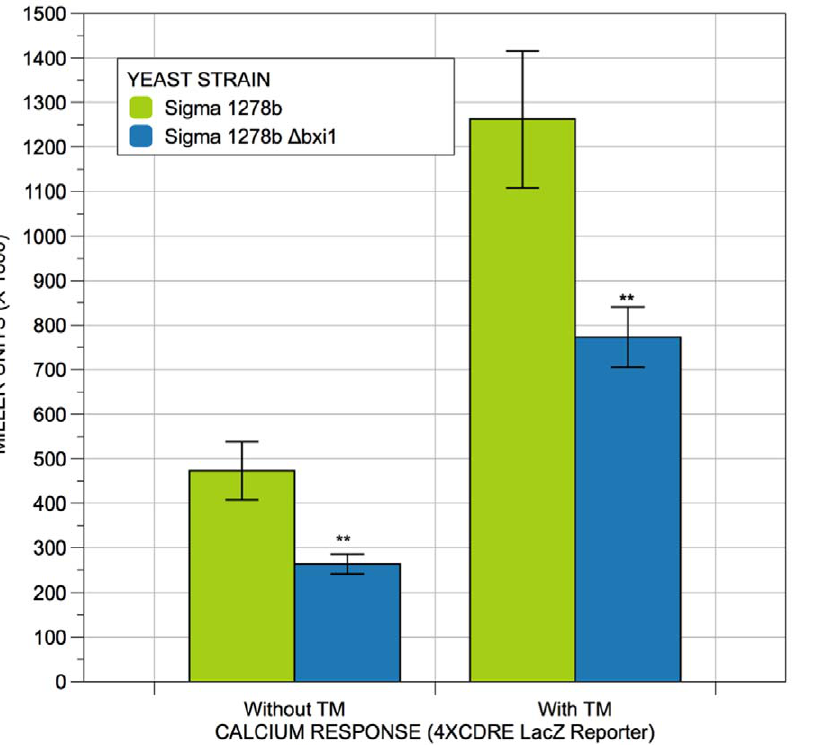
Figure 7. Deleting BXI1 diminishes calcium signaling in the absence and presence of unfolded proteins in the ER. Cells of the indicated genotype in the S 1278b strain background were transformed with a 4XCDRE-lacZ reporter, grown overnight in selective media at 30 u C. They were then resuspended in fresh media and allowed to reach exponential phase (an approximate OD 600 value of 0.4). Next, they were resuspended in fresh media or in fresh media containing 0.6 m g/ml TM and allowed to grow at 30 u C for three hours. b -galactosidase assays with the colorimetric substrate o -nitrophenyl- b -D-galactopyranoside (ONPG) were then performed and quantified using the permeabilized cell method as previously described. [37,41,42] The differences in b -galactosidase levels were deemed statistically significant by the Student’s t-test (p , 0.05). Error bars indicate standard deviations for trials with at least three independent transformants.